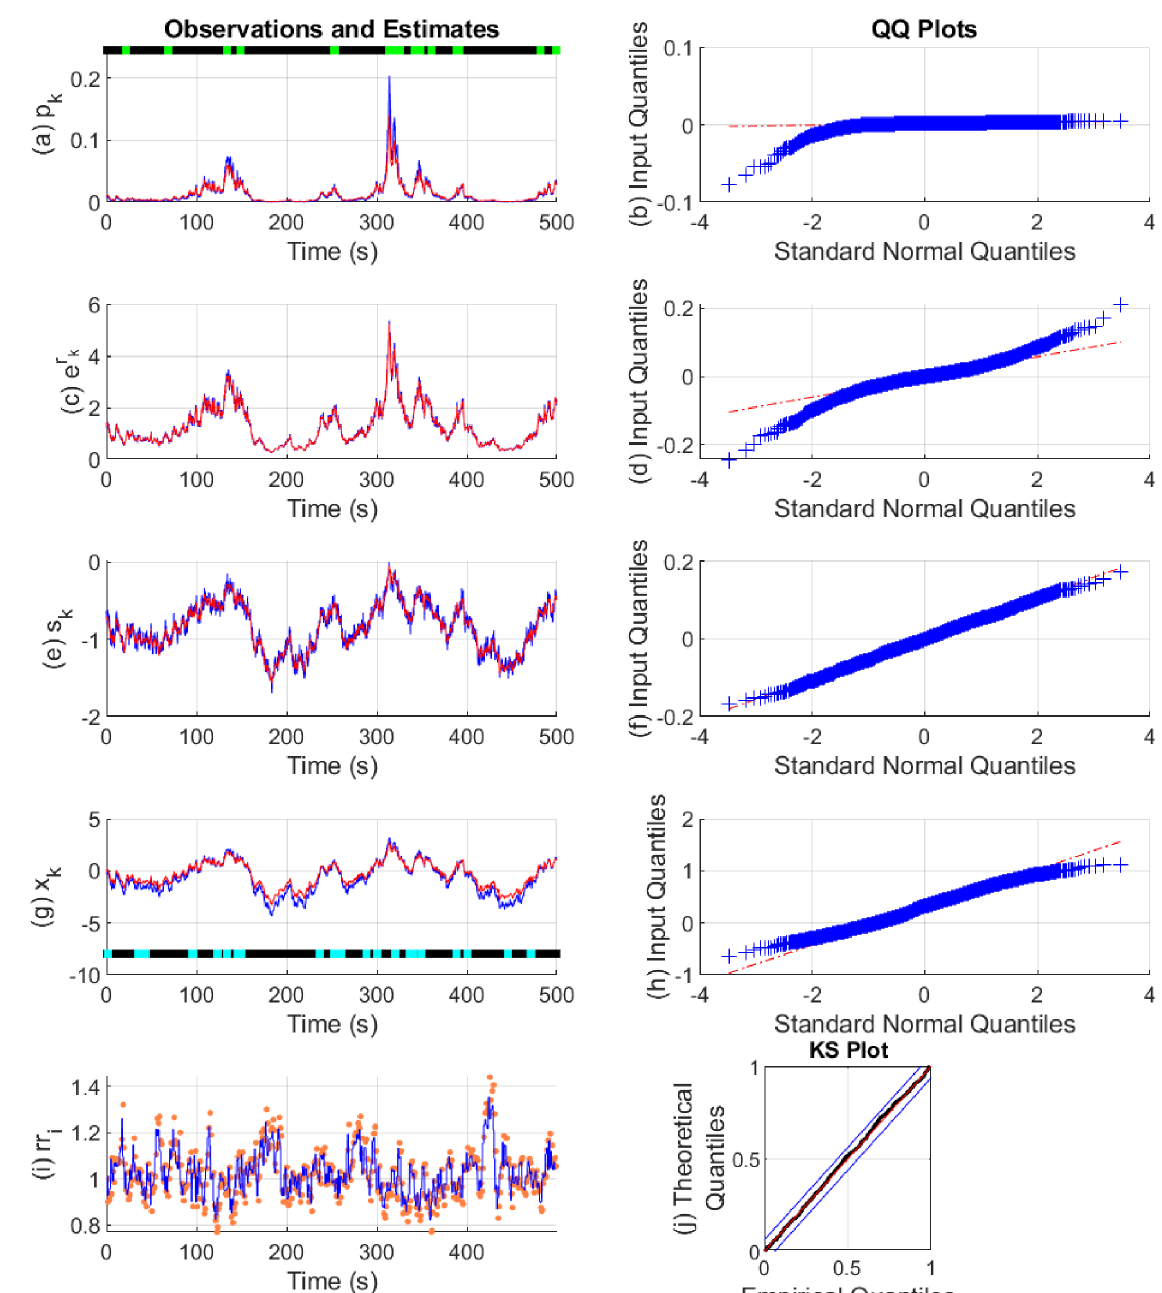
Fig 6. State estimation with simulated data ( ^ p > 0 : 01 ). The sub-panels respectively depict, (a) the Bernoulli trial probabilities p k (blue), their 0 estimate (red) and the presence or absence of binary observations (light green and black dots); (b) the quantile-quantile (QQ) plot for the residual error of p k ; (c) the exponent of r k (blue) and its estimate (red); (d) the QQ plot for the residual error of r k ; (e) s k (blue) and its estimate (red); (f) the QQ plot for the residual error of s ; (g) the arousal state x (blue), its estimate (red) and the presence or absence of stimuli I k k driving the state (cyan and blacks dots); (h) the QQ plot for the residual error of x k ; (i) the sequence of RR-intervals rr i (orange dots) and the estimated RR-interval mean μ (solid blue line); (j) the KS plot for the heartbeats.